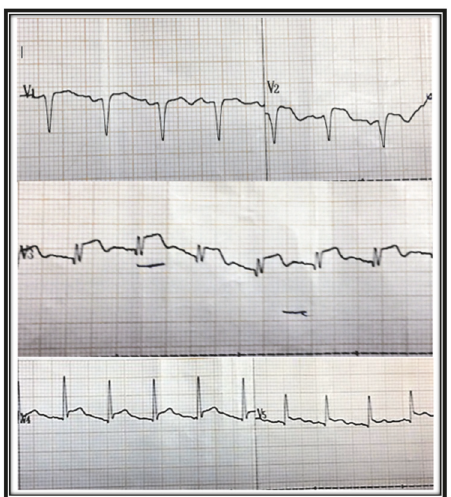
Figure 1: ECG of the patient after the cardiac arrest showing ST elevation in anterior leads.